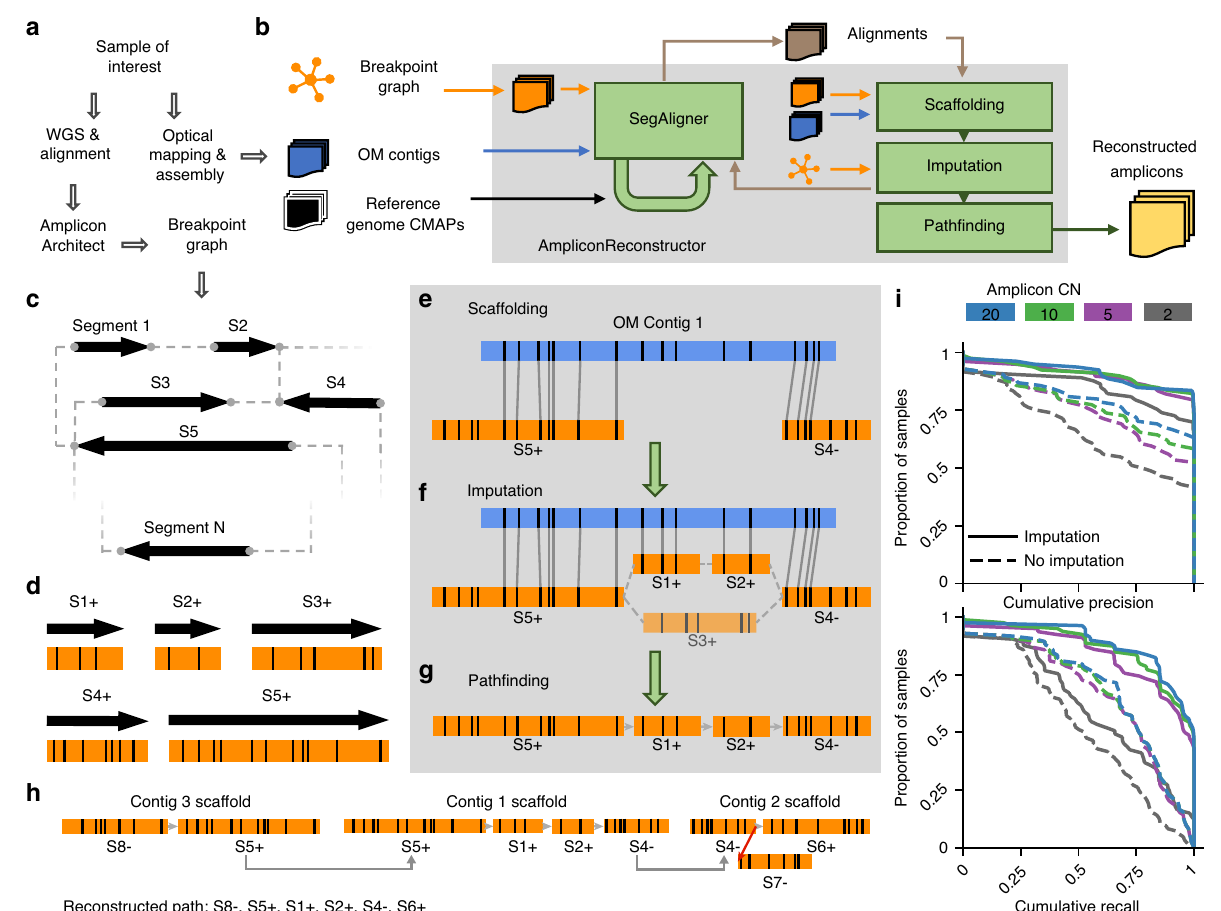
Fig. 1 AmpliconReconstructor (AR) overview. a Work fl ow to produce the necessary inputs for AR. AR accepts OM data in the consensus map (CMAP) format. b High-level overview of the AR method, where the inputs and outputs are shown outside the gray box representing the AR wrapper. The green loop-back arrow on the SegAligner module represents the identi fi cation of reference segments not encoded in the breakpoint graph. c A breakpoint graph with N segments. d In silico digestion of breakpoint graph segments (orientation given by + / − ) from ( c ) to produce graph OM segments. e Alignment of graph OM segments to OM contigs produces a scaffold of segment-contig alignments. f AR uses the structure of the breakpoint graph to identify paths between scaffold alignment endpoints which are also paths in the breakpoint graph. AR generates composite optical maps from combined path segments to score each candidate path against the gap in the scaffold. g AR identi fi es a candidate path with maximum score out of the possible imputed paths between two alignments. h AR links individual scaffolds sharing overlap between graph segments. The resulting graph has two types of edges, allowed (gray) and forbidden (red). i Cumulative precision and recall curves based on simulated OM data for AR using SegAligner, calculated with the Length (bp) LCS metric. Line color indicates the copy number (CN) of the simulated amplicon. Source data are provided as a Source data fi